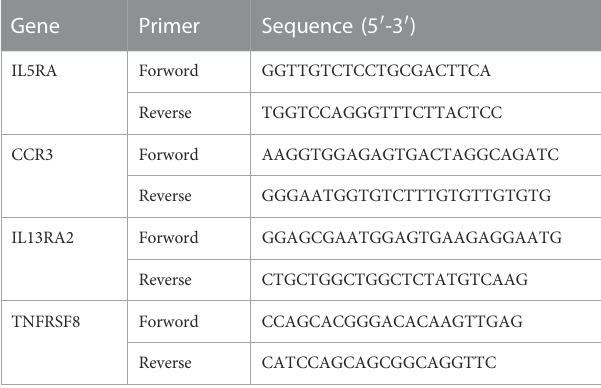
TABLE 2 Nucleotide sequences of primers used in